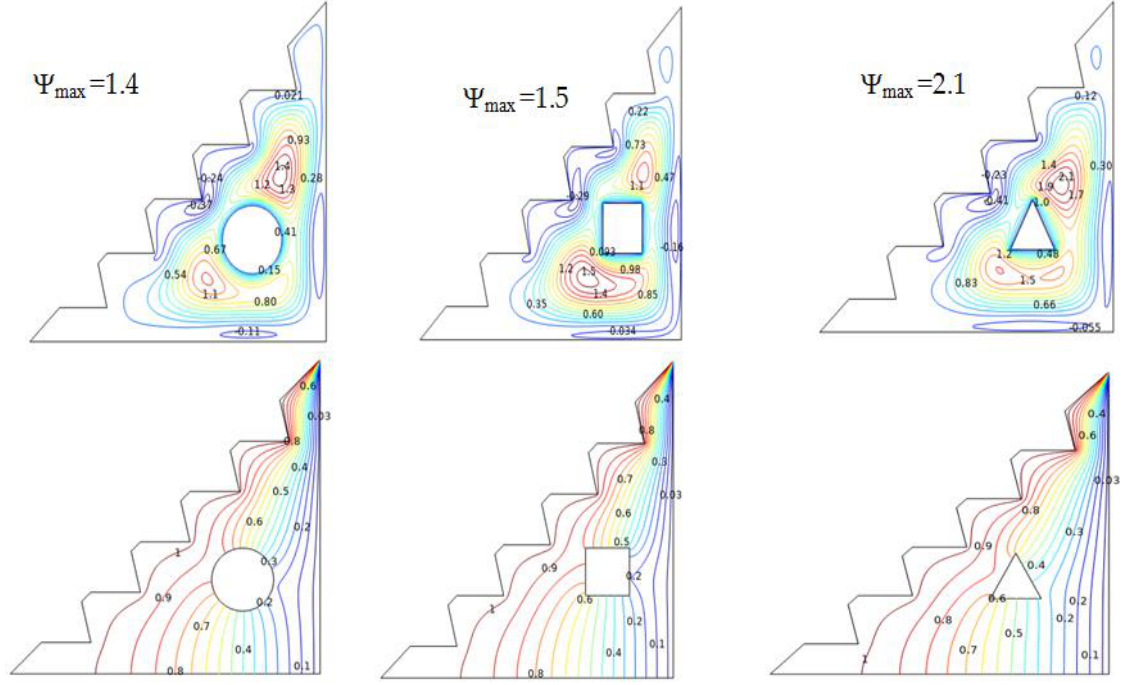
Figure 10. Streamlines and isotherms for w = 0, Ha = 0, Ra = 10 5 , and ϕ = 0.02.